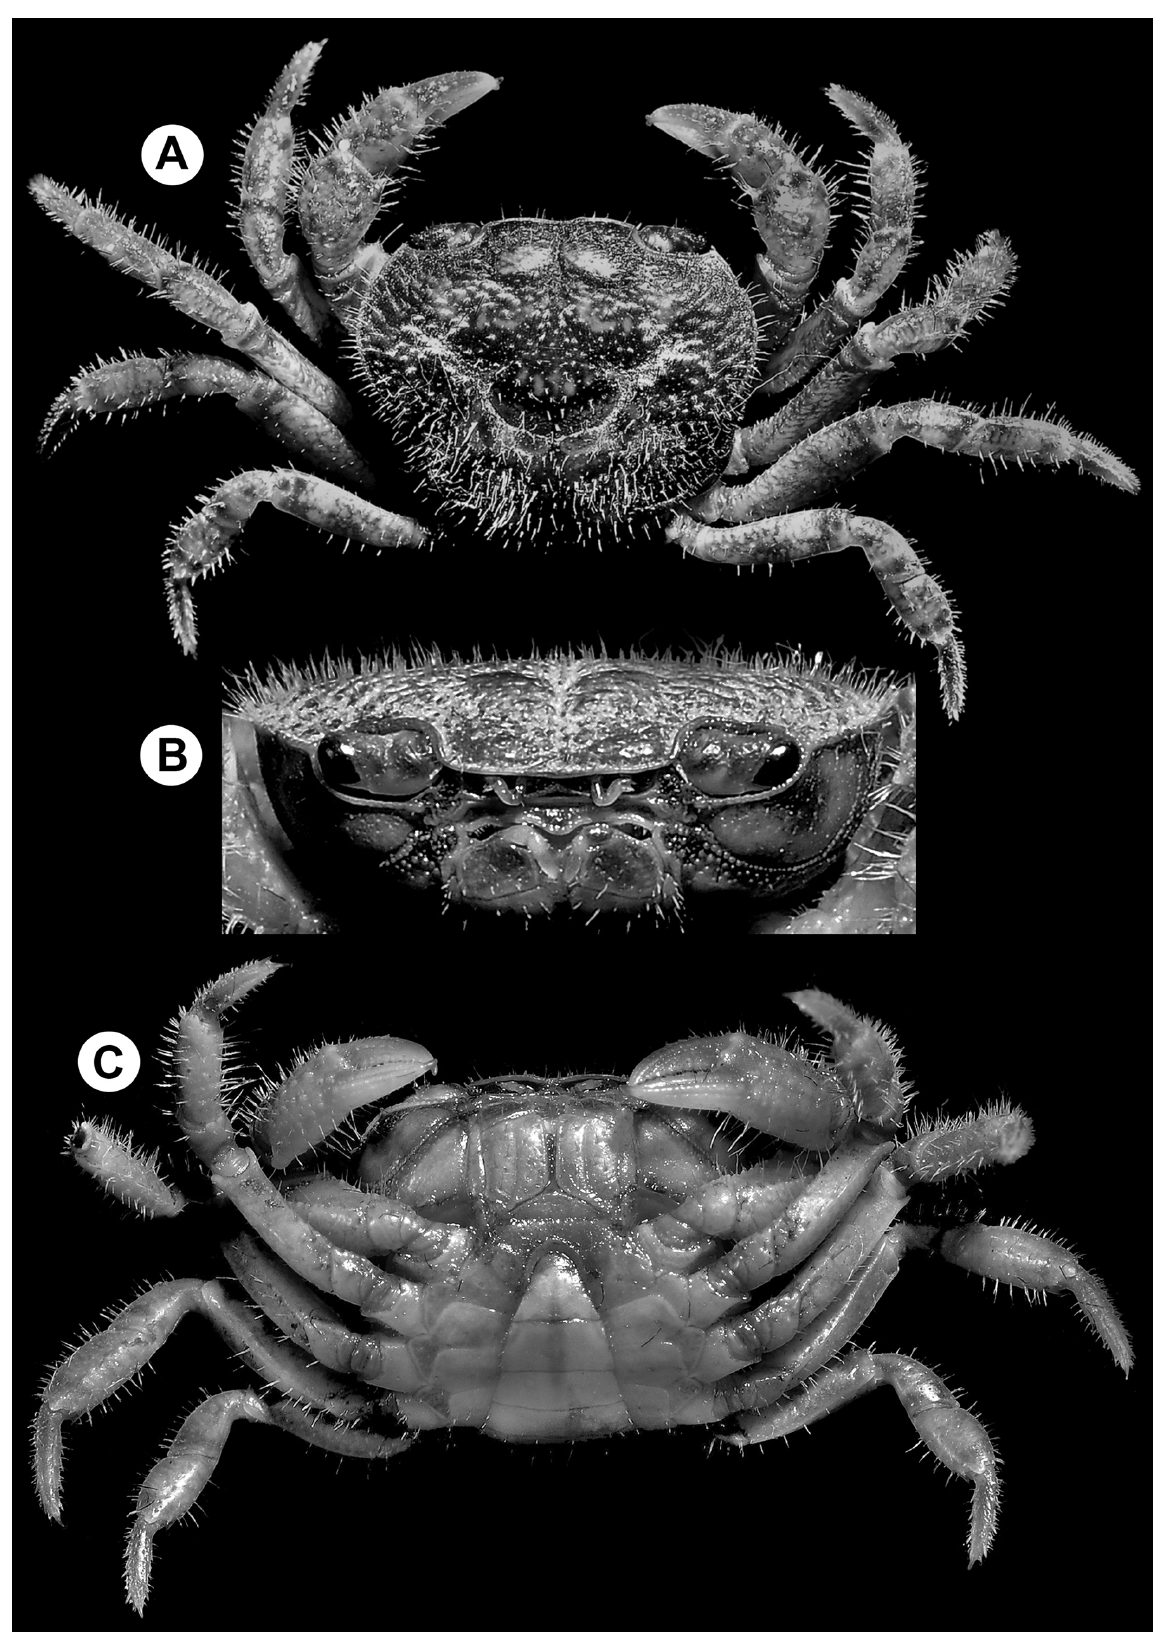
Figure 5. Abormon capillosum sp. nov., holotype male (10.2 × 8.5 mm) (ZSIK C.8610/2). A , overall dorsal view; B , frontal view of cephalothorax; C , overall ventral